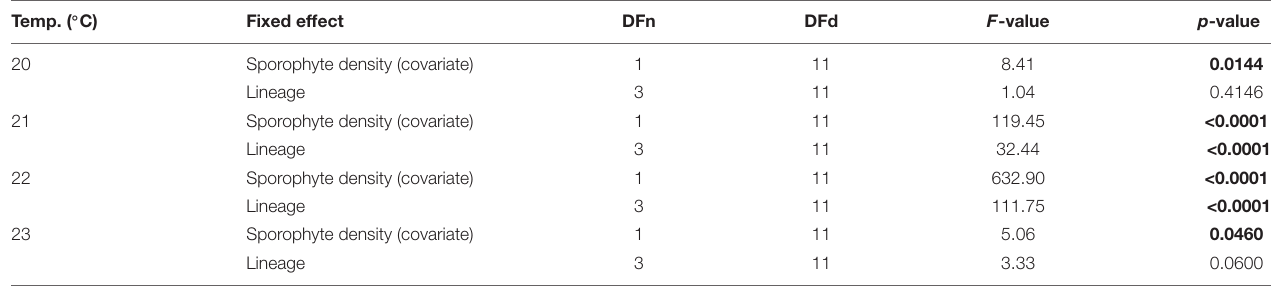
TABLE 1 | Results of linear models to examine fractions of unbleached Laminaria digitata sporophytes in the upper survival temperature experiment on microscopic sporophytes (experiment 1). Temp. ( ◦